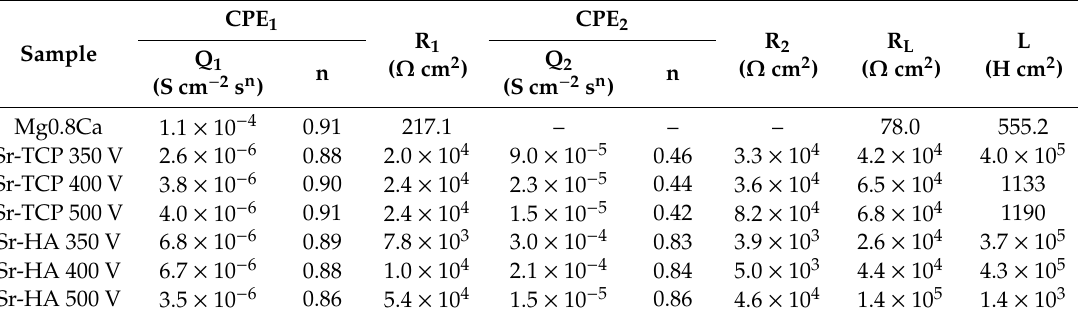
Table 3. Calculated parameters of the EECs elements